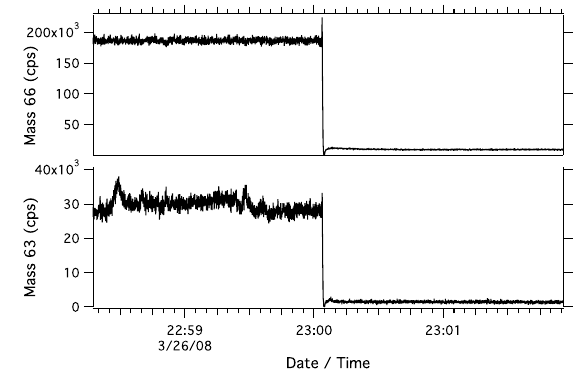
Fig. 1. Mass scans of ambient air with added d-3 DMS. Large wa- ter cluster peaks at masses 55 and 73 are the dominant ions. (a) Air sample. (b) Air sample through gold-bead blanking column, showing removal of DMS peaks at masses 63 and 66.